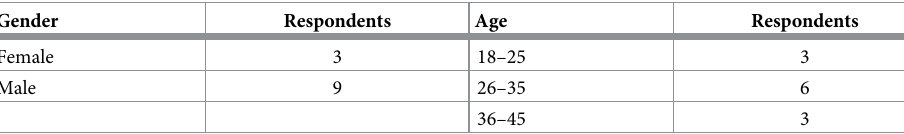
Table 2. Number of survey respondents by gender and